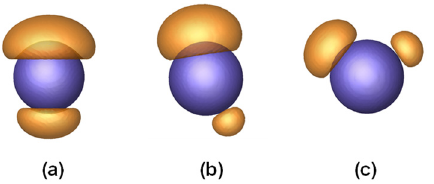
Figure 5. Two-patch patterns formed by phase separation of polymers tethered on a nanoparticle. The grafting densities are ( a ) 0.50 R g − 2 , ( b ) 0.35 R g − 2 , and ( c ) 0.20 R g − 2 , respectively. The radius R np of the nanoparticle is 1.8 R g , and the fraction f mb of mobile brushes is 0.7.